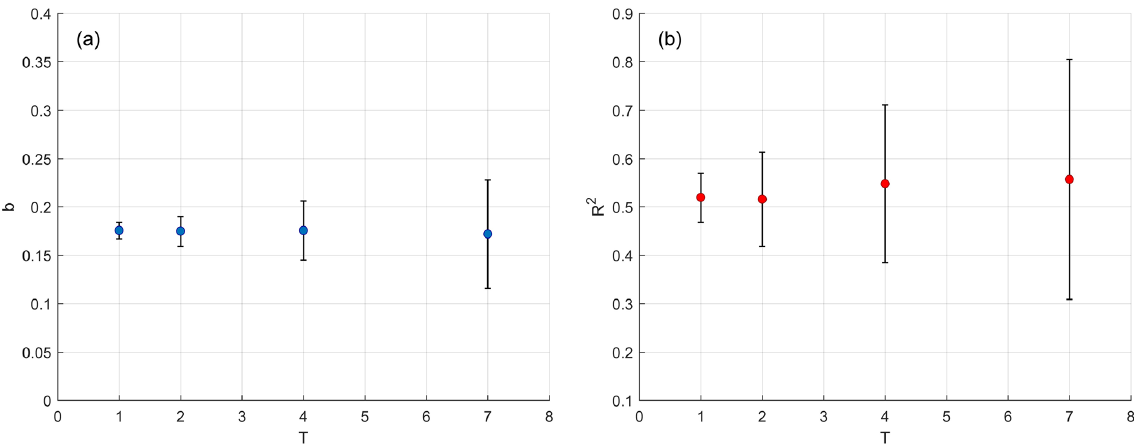
Figure D1. Plot of resampled b (a) and R 2 (b) mean values and standard deviations as a function of the mean frequency of the resampling T calculated for total active length ( L ) and discharge ( Q